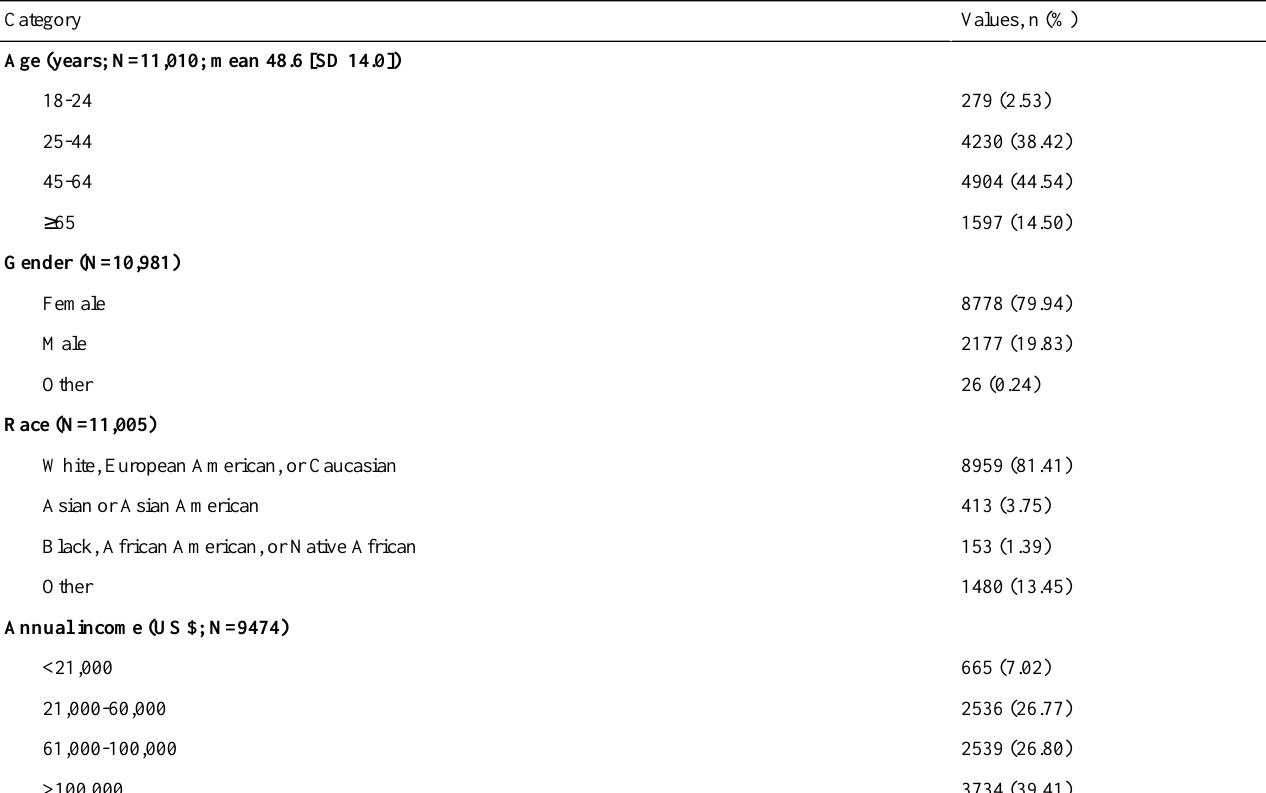
Values, n (%)Category